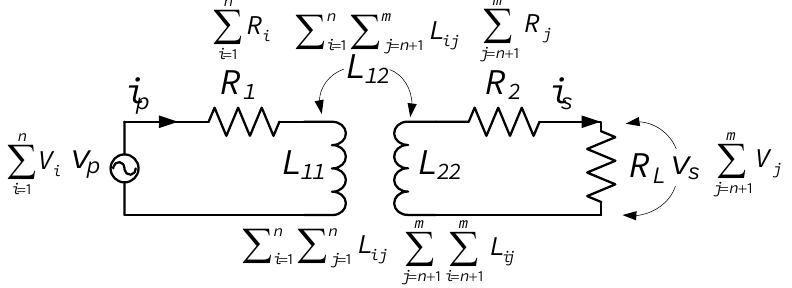
Figure 6. Equivalent single coil pair for a system of coils with ( 1,2,..., n ) coils in the primary and ( n + 1, n + 2,..., m ) coils in the pickup.